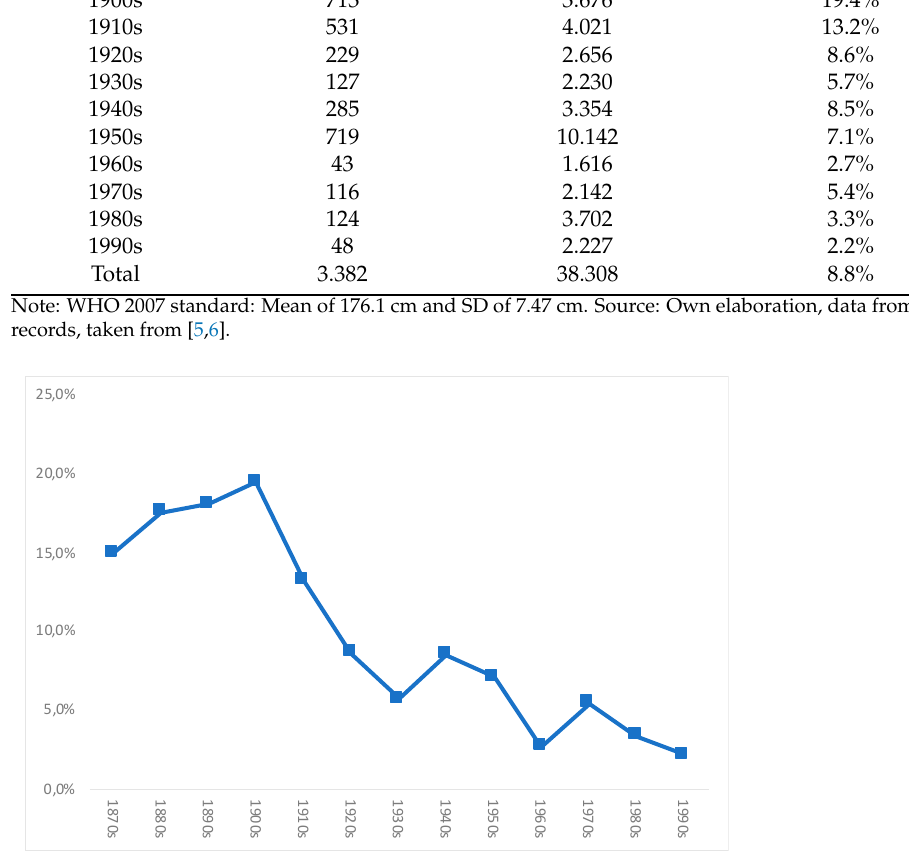
Figure 2. Evolution of moderate and severe stunting in Chile (as a share of male population, %), per decade of birth. Source: Table 1.